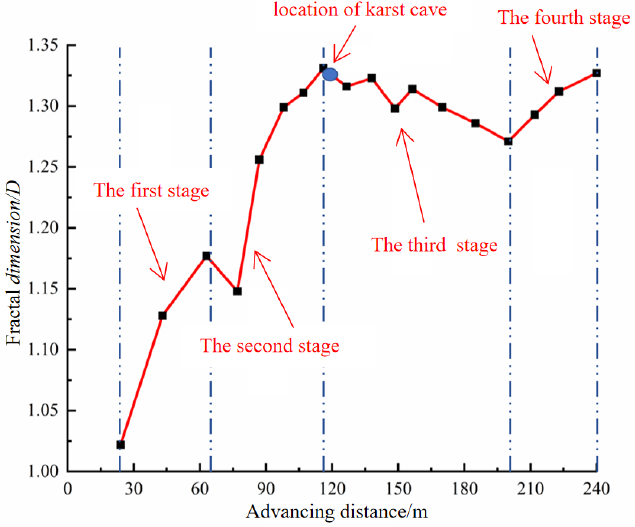
Figure 10. Bilogarithmic curves of mining-induced fissure network with different advancing de- grees. ( a ) Advancing distance 87 m; ( b ) Advancing distance 107 m; ( c ) Advancing distance 127 m; ( d ) Advancing distance 138 m; ( e ) Advancing distance 156 m; ( f ) Advancing distance 185 m.